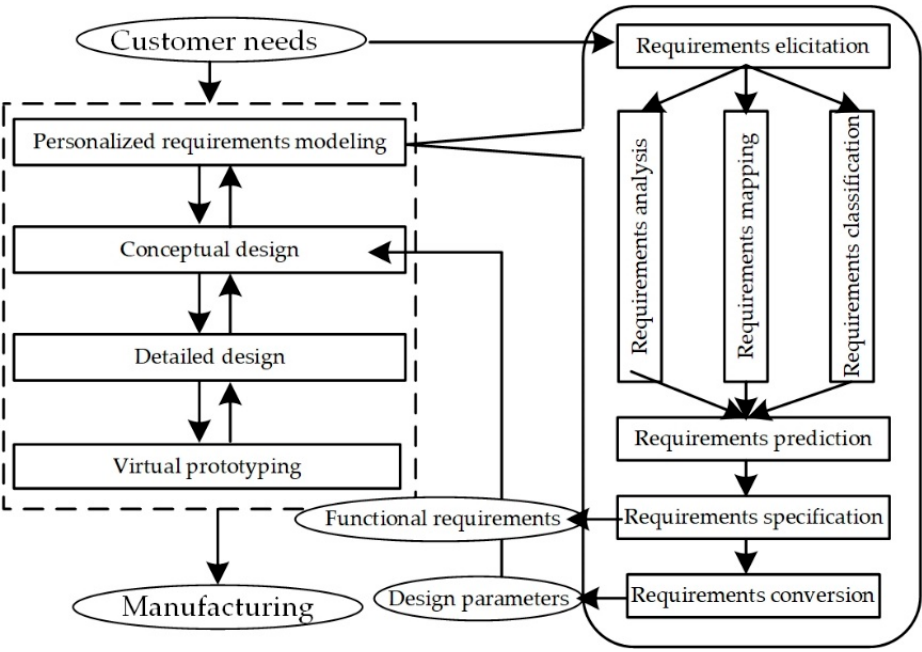
Figure 1. Design activities in product customization and workflow of requirements modeling.